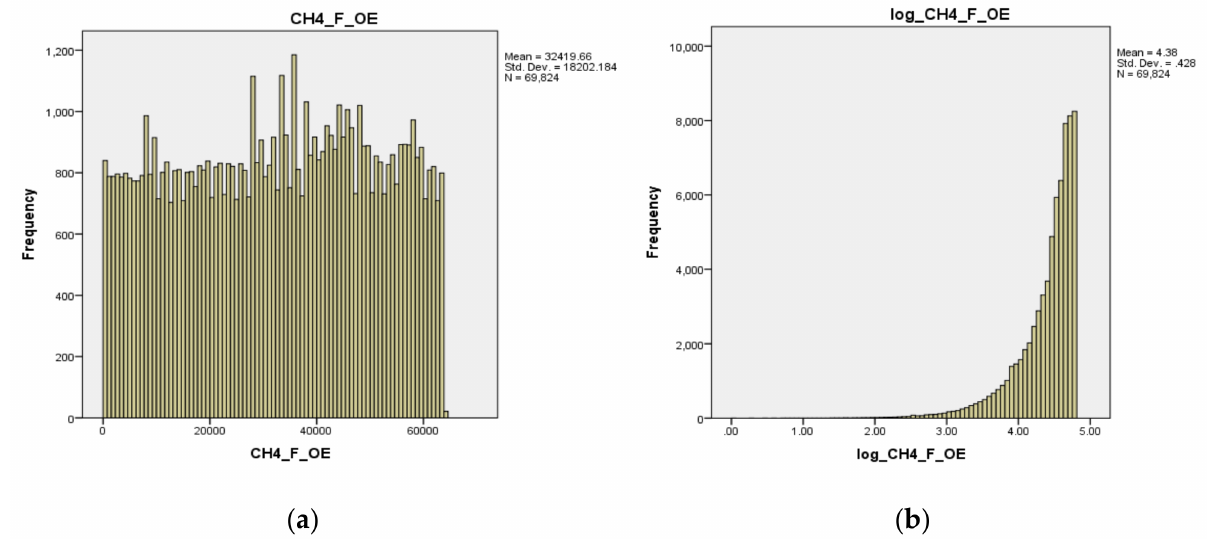
Figure 3. Histogram of F-OE-CH4 component data vs. log transform with F-OE-CH4 components for NG: ( a ) histogram of component 6 named by CH4-F-OE, and ( b ) Log10 scale transformed histogram of